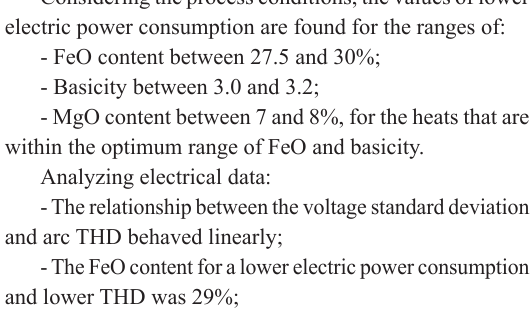
Figure 8: Relationship between the FeO content and the THD standard.